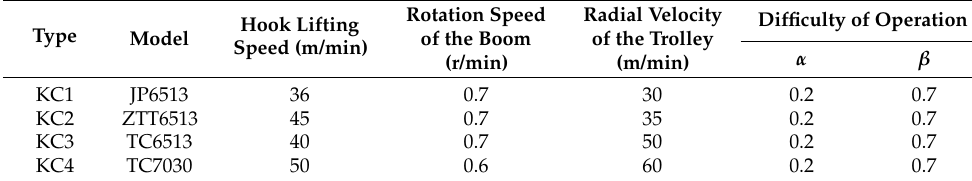
Table 4. Operating rates of optional tower cranes.